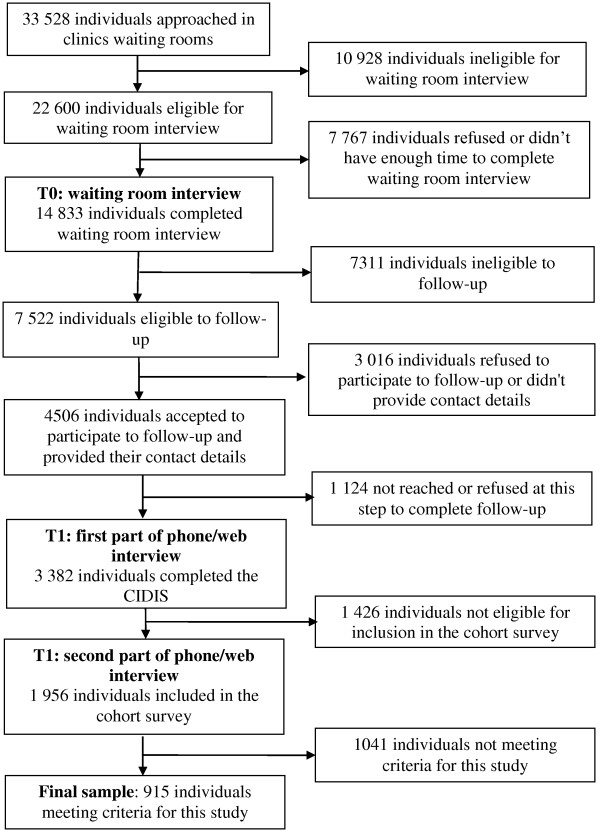
Recruitment flow-chart, Dialogue Project.